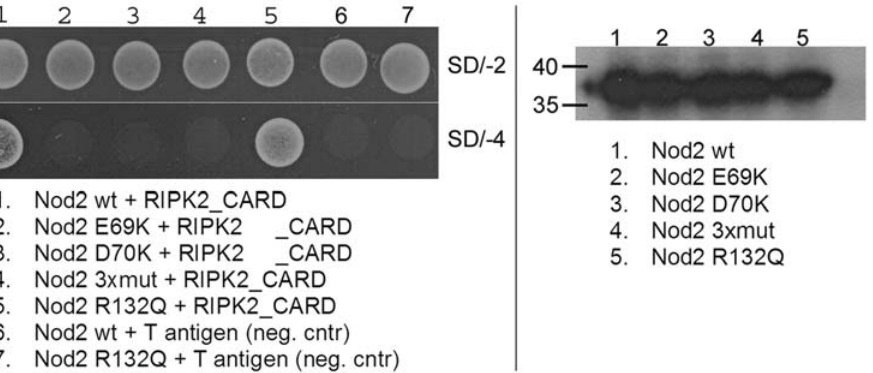
Figure 4. Interaction of distinct NOD2 mutants with RIPK2. Left panel , Yeast two-hybrid analysis. NOD2 CARD1 + 2 interacts with RIPK2 CARD (column 1). No interactions were observed for NOD2 variants harboring a disrupted acidic patch (transformation 2, 3, and 4). An unrelated mutation not affecting the interaction interface had no effect (column 5). Right panel , Autoradiography of an in vitro transcription/translation of NOD2 proteins. NOD2 constructs were expressed using similar amounts of DNA and